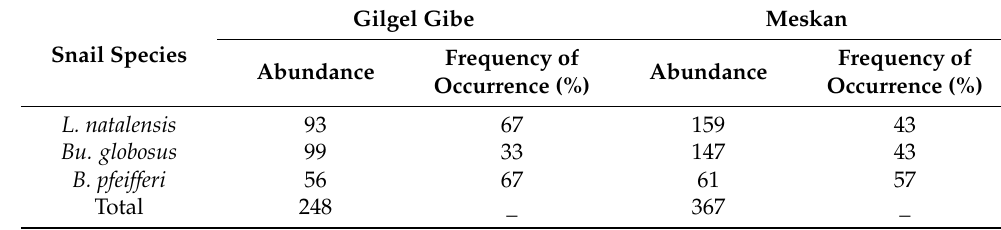
Table 1. Abundance and frequency of occurrence of freshwater snails in the Gilgel Gibe and Meskan area, Ethiopia.